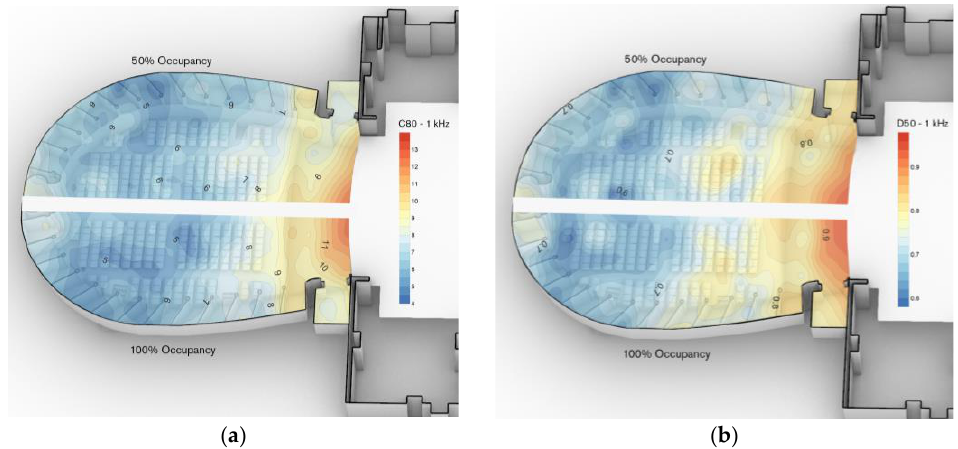
( d ) Figure 11. Simulated results of the acoustic parameters: EDT ( a ), T 20 ( b ) C 80 ( c ) and D 50 ( d ). The graphs in Figure 11 show that with a medium-high upholstery of the seats, the presence of an audience does not result in any appreciable difference [26], meaning that the acoustics of the Ponchielli theater do not change and are independent of the degree of occupancy [27]. This outcome is positive, especially for actors and musicians who do not have to change their effort between rehearsal and a live show in the presence of the public